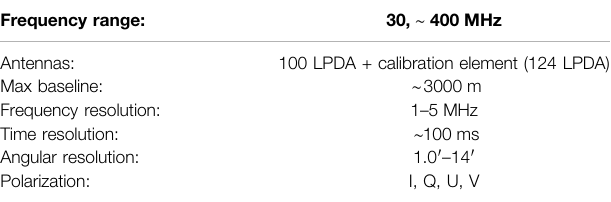
TABLE 3 | Performance of MUSER in metric and decametric wave